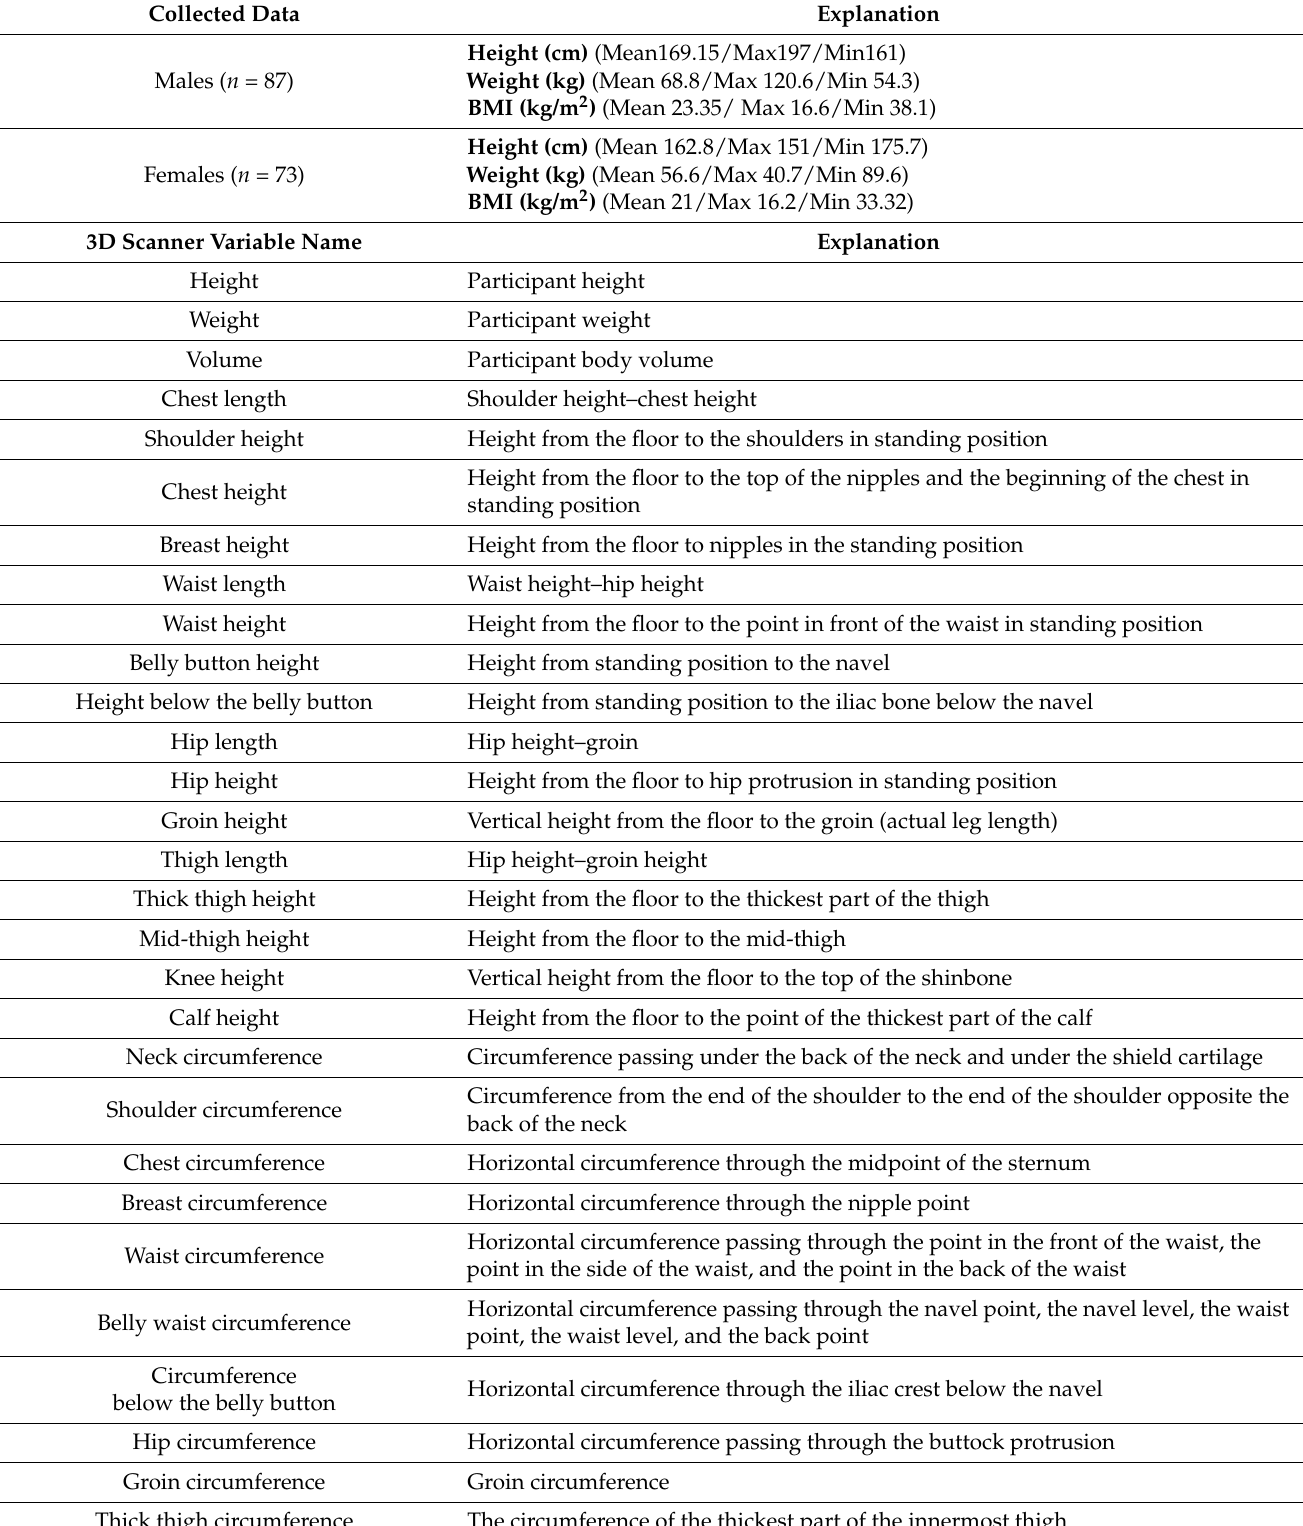
Table 1. Variables derived from the 3D scanner and their descriptions (Body Landmarks: ISO-7250, Date: 5 April 2021–24 December